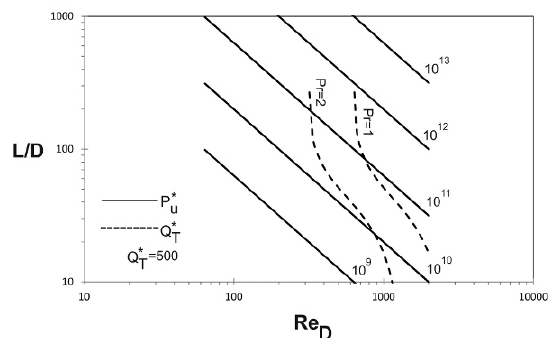
Figure 11. Φ W/L groupversustheReynoldsnumberfordifferentdi- mensionless heat transfer conductance and fluid